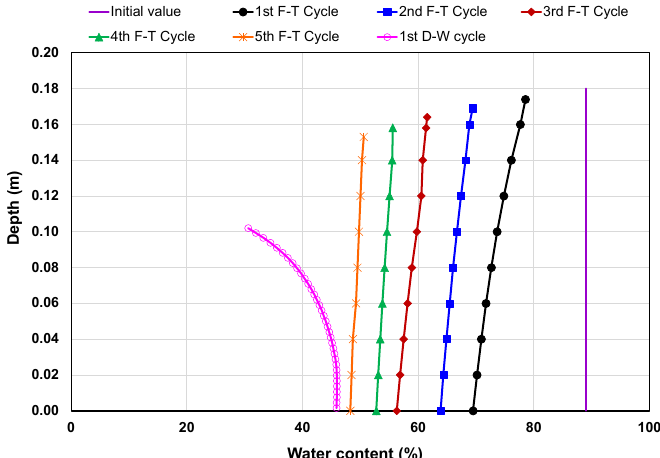
Figure 5. Water content profile simulation of centrifuged tailings at a temperature gradient of 0.083 °C/mm.